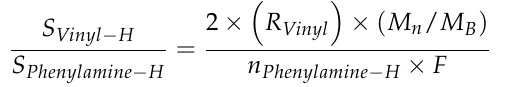
Figure 2. 1 H NMR spectra; ( a ) N-LqBR; ( b ) amino-LqBR ( ★ CDCl 3 solvent, ◆ THF solvent).